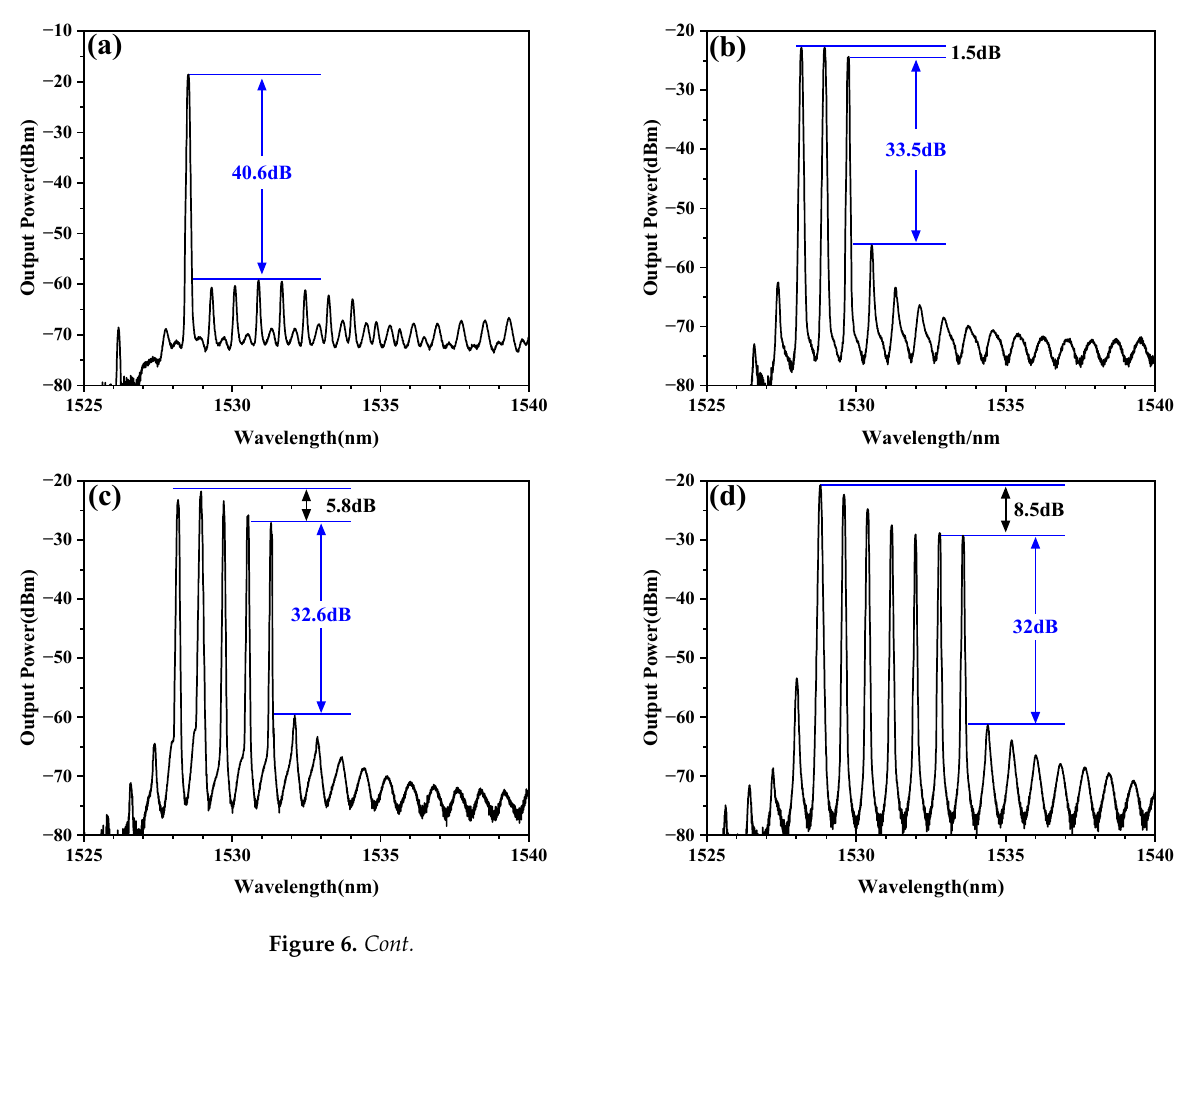
7 of 14 Figure 5. Measured transmission spectra of the composite filter at different PC angles: ( a ) small angle, ( b ) large angle. 3. Experimental Setup and Results